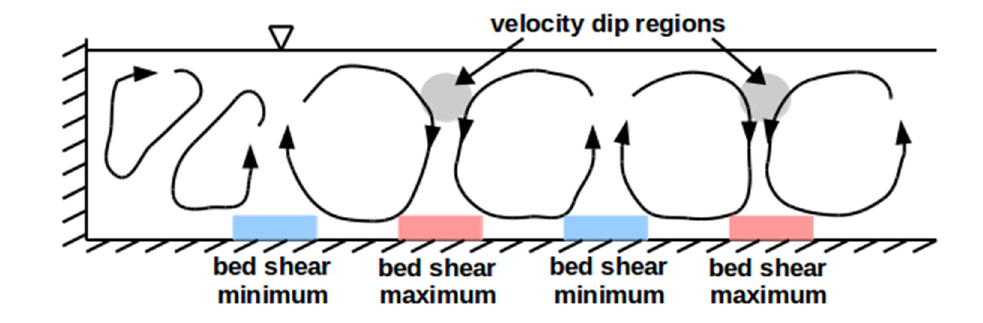
Figure 1. Organization of secondary currents in open channel flows, with associated velocity dip regions and bed shear maxima and